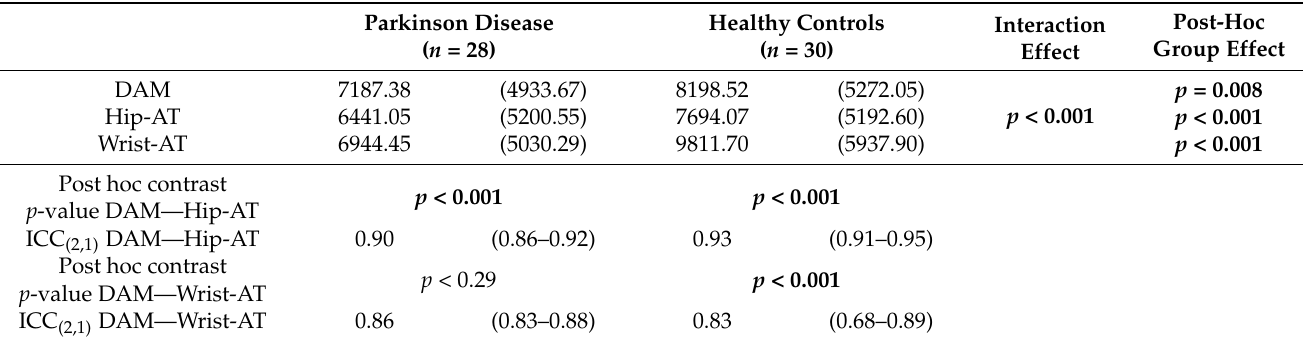
Table 2. Criterion validity.